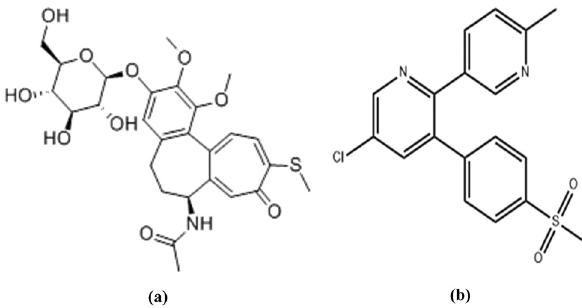
Figure 1: Chemical structures of ( a ) TCC ( N -[( 7S )- 1,2 - dimethoxy - 10 - methylsulfanyl - 9 - oxo - 3 -[( 2S,3R,4S,5S,6R )- 3,4,5 - trihydroxy - 6 -( hydroxy - methyl ) oxan - 2 - yl ] oxy - 6,7 - dihydro - 5H - benzo [ a ] heptalen - 7 - yl ] acetamide ) and ( b ) ETXB ( 5 - chloro - 2 -( 6 - methylpyridin - 3 - yl )- 3 - ( methylsulfonyl phenyl ) pyridine )